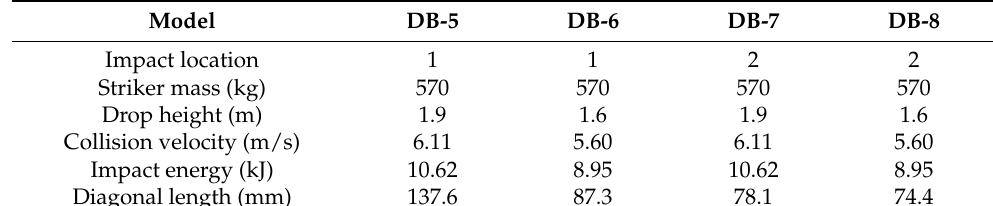
Table 4. Conditions of the collision tests: fracture damage.